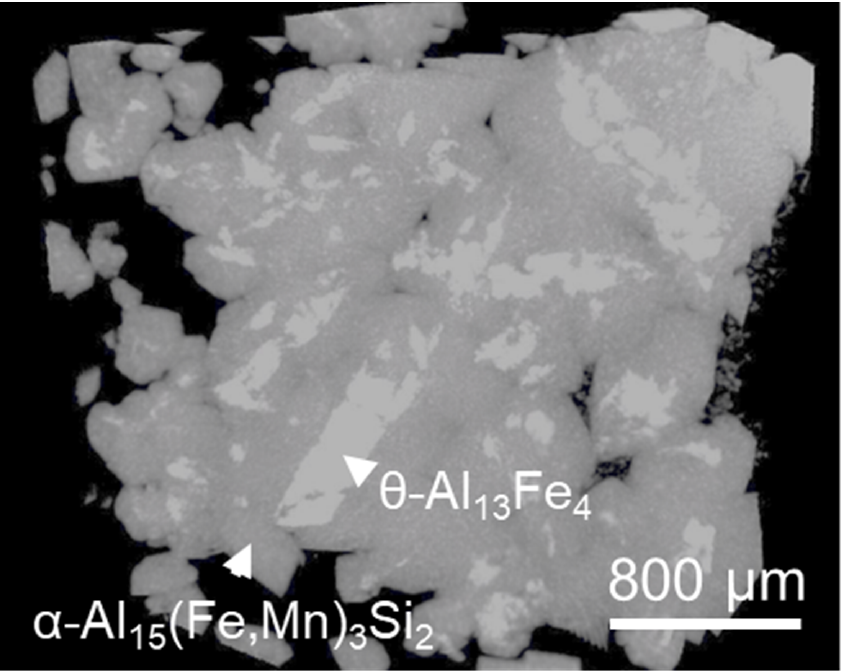
Figure 8. X-ray computed tomography (CT) image showing the cross-section of Al-5Mg-2Si-0.6Mn-1.0Fe alloy solidified at 0.01 K/s indicated that the PIMCs compacted particles contain central brighter particles indicating a different FIMC to the surface structure [66].